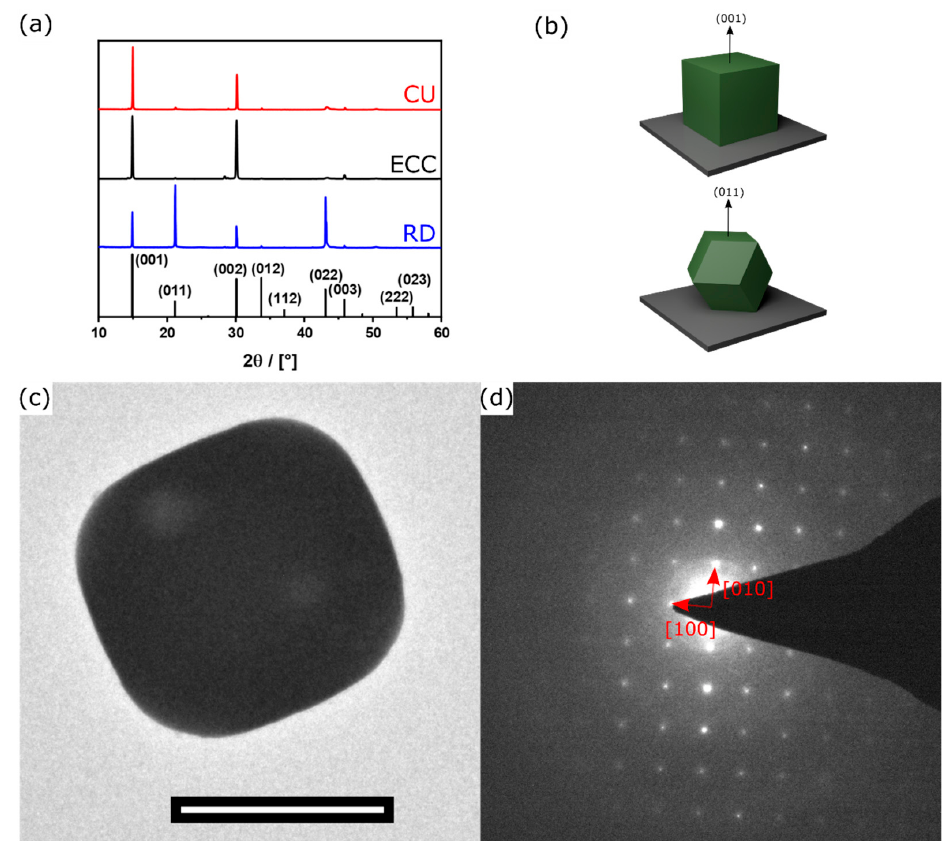
Figure 4. ( a ) PXRD pattern from RD (blue), ECC (black), and CU (red) microcrystal and the reference pattern of CH 3 NH 3 PbBr 3 (black; no. 252415.cif) [ 62 ]; ( b ) Orientation of CU- (top) and RD- (bottom) microcrystals on the substrate; ( c ) TEM micrograph (scale bar = 500 nm); and ( d ) ED of one single CU-microcrystal.